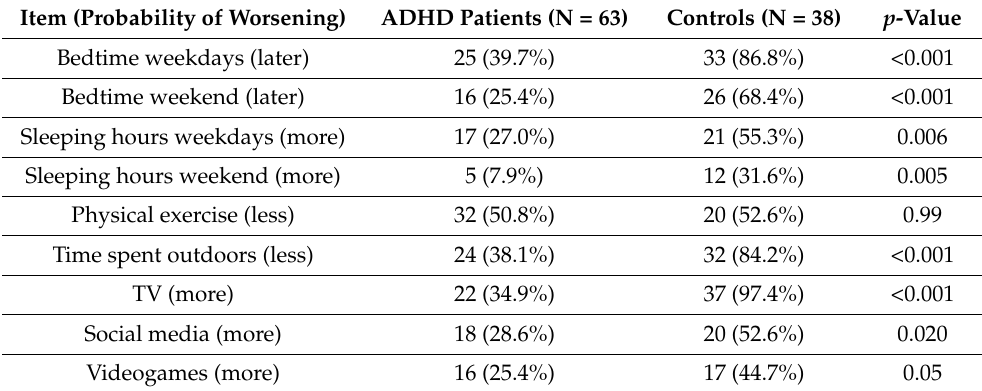
Table 4. Differences between ADHD patients and controls, in the likelihood of worsening in items of the domains “daily behaviors” and “use of digital